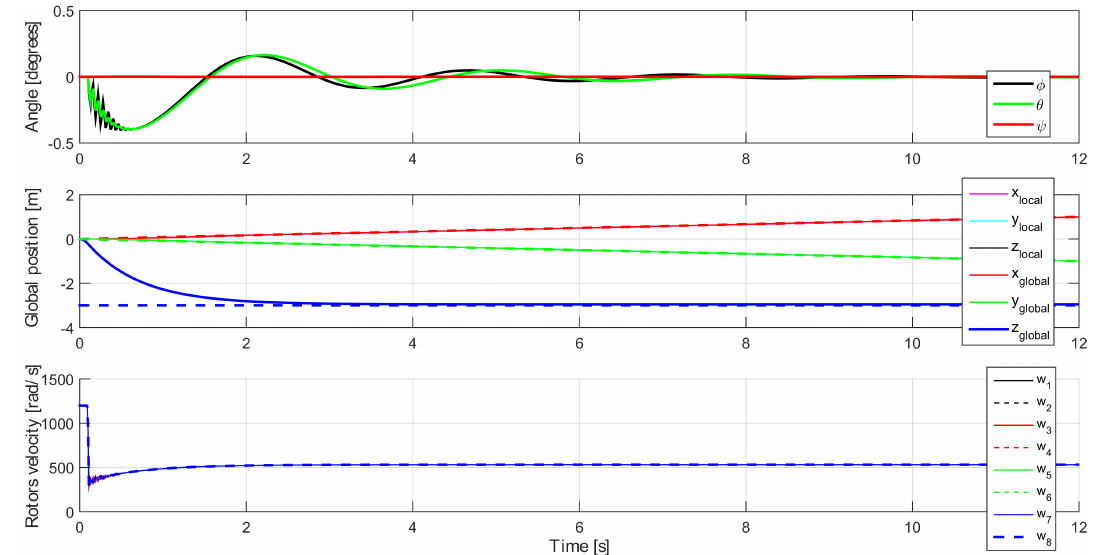
Figure 8. Results of experiment no. 1. From above: Euler’s angles, positions (in X , Y , Z ∈ BF and in x , y , z ∈ EF coordinates) and rotors velocity for simulated UAV.